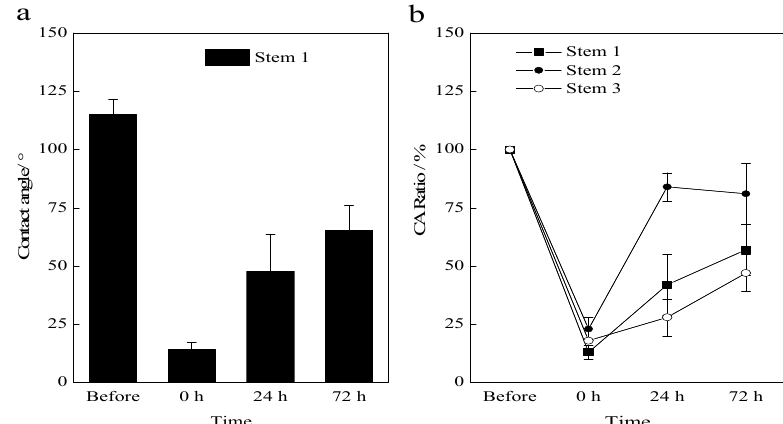
Figure 2. Contact angle: ( a ) contact angle changes of stem 1 during aging, ( b ) contact angle ratio of plasma treated specimens compared to untreated control during aging.